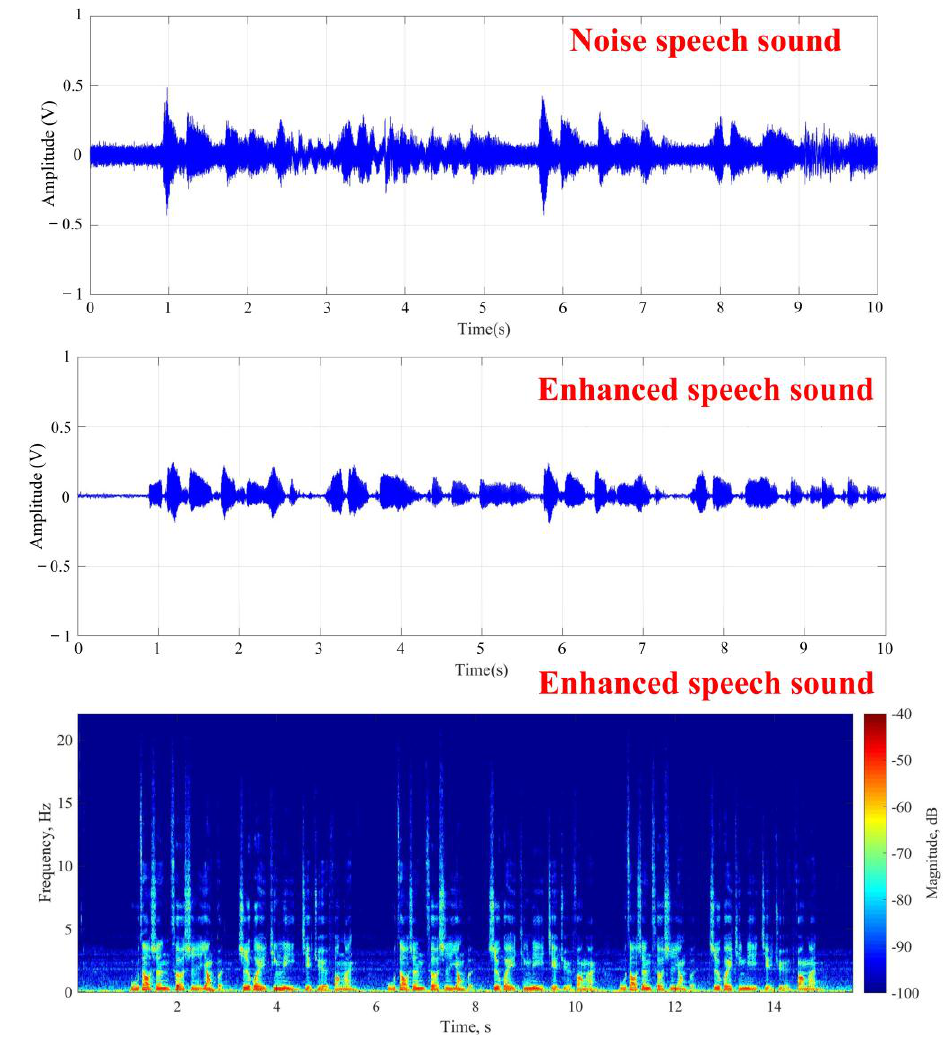
Figure 9. Results of target speech enhancement in white noise environment.